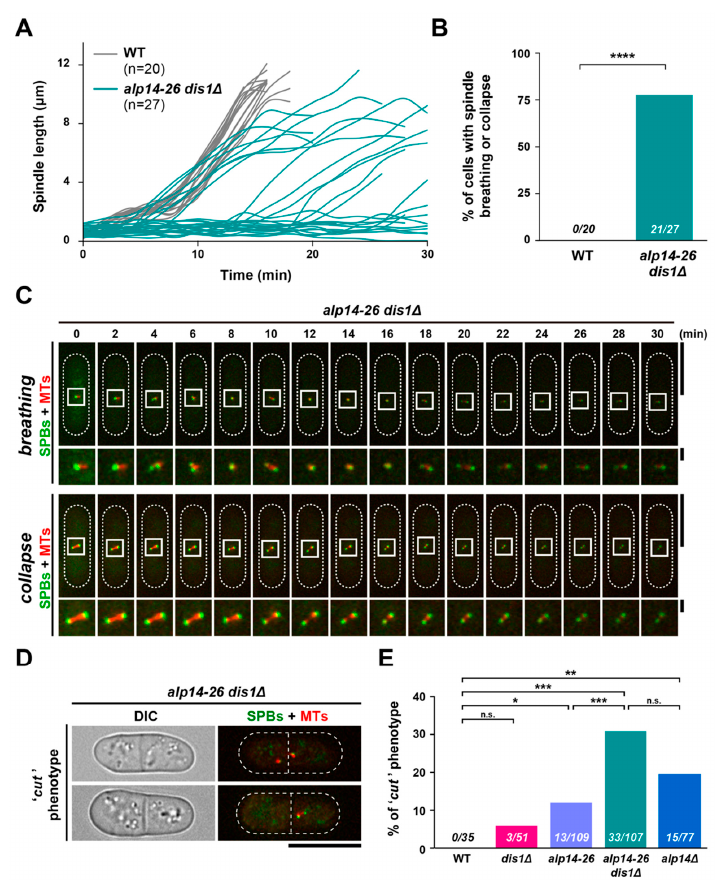
Figure 4. Short spindles are often collapsed in alp14-26dis1 ∆ , leading to the lethal “cut” phenotype. Exponentially growing cells at 27 °C were shifted to 36 °C for 2 h. Spindle MTs (mCherry-Atb2; red) and SPBs (Cut12-GFP ( A – C ) or Plo1-GFP ( D and E ); green) were visualised. ( A ) Plots of spindle length over time. Spindle length (the distance between SPBs) obtained from live cell imaging was measured over time in wild-type (grey, n = 20) and alp14-26 ∆ dis1 ∆ cells (teal, n = 27). ( B ) Percentage of cells displaying spindle breathing or collapse. The sample numbers are shown ( n = 20 for wild-type and n = 27 for alp14-26 ∆ dis1 ∆ cells). As the distinction of the spindle behaviour between breathing and collapse is sometimes equivocal, these two phenotypes are combined in this graph. The p -value is derived from a two-tailed Chi-squared test (**** p < 0.0001). ( C ) Time-lapse images of a mitotic alp14-26dis1 ∆ cell displaying spindle breathing or collapse. Representative images of breathing (top) or collapse (bottom) are shown. Images were taken at 2 min intervals after 2 h incubation at 36 ◦ C. Cell peripheries are indicated with dotted lines (the top part of each row). The areas containing SPBs and spindle microtubules are marked by square boxes and are enlarged (the bottom part of each row). Scale bars, 10 µ m (top) and 1 µ m (bottom). ( D ) Representative images of alp14-26 ∆ dis1 ∆ cells exhibiting the “cut” phenotype. Scale bar, 10 µ m. ( E ) The percentage of cells displaying the “cut” phenotype. All p -values are derived from a two-tailed Chi-squared test (* p < 0.05; ** p < 0.01; *** p < 0.001; n.s., not